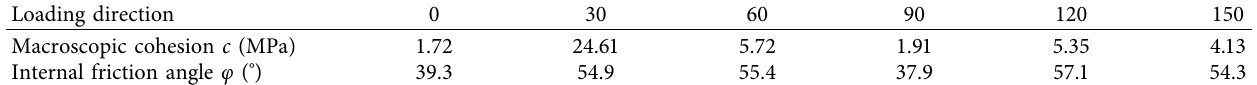
Table 6: Equivalent Mohr–Coulomb strength parameters under different loading